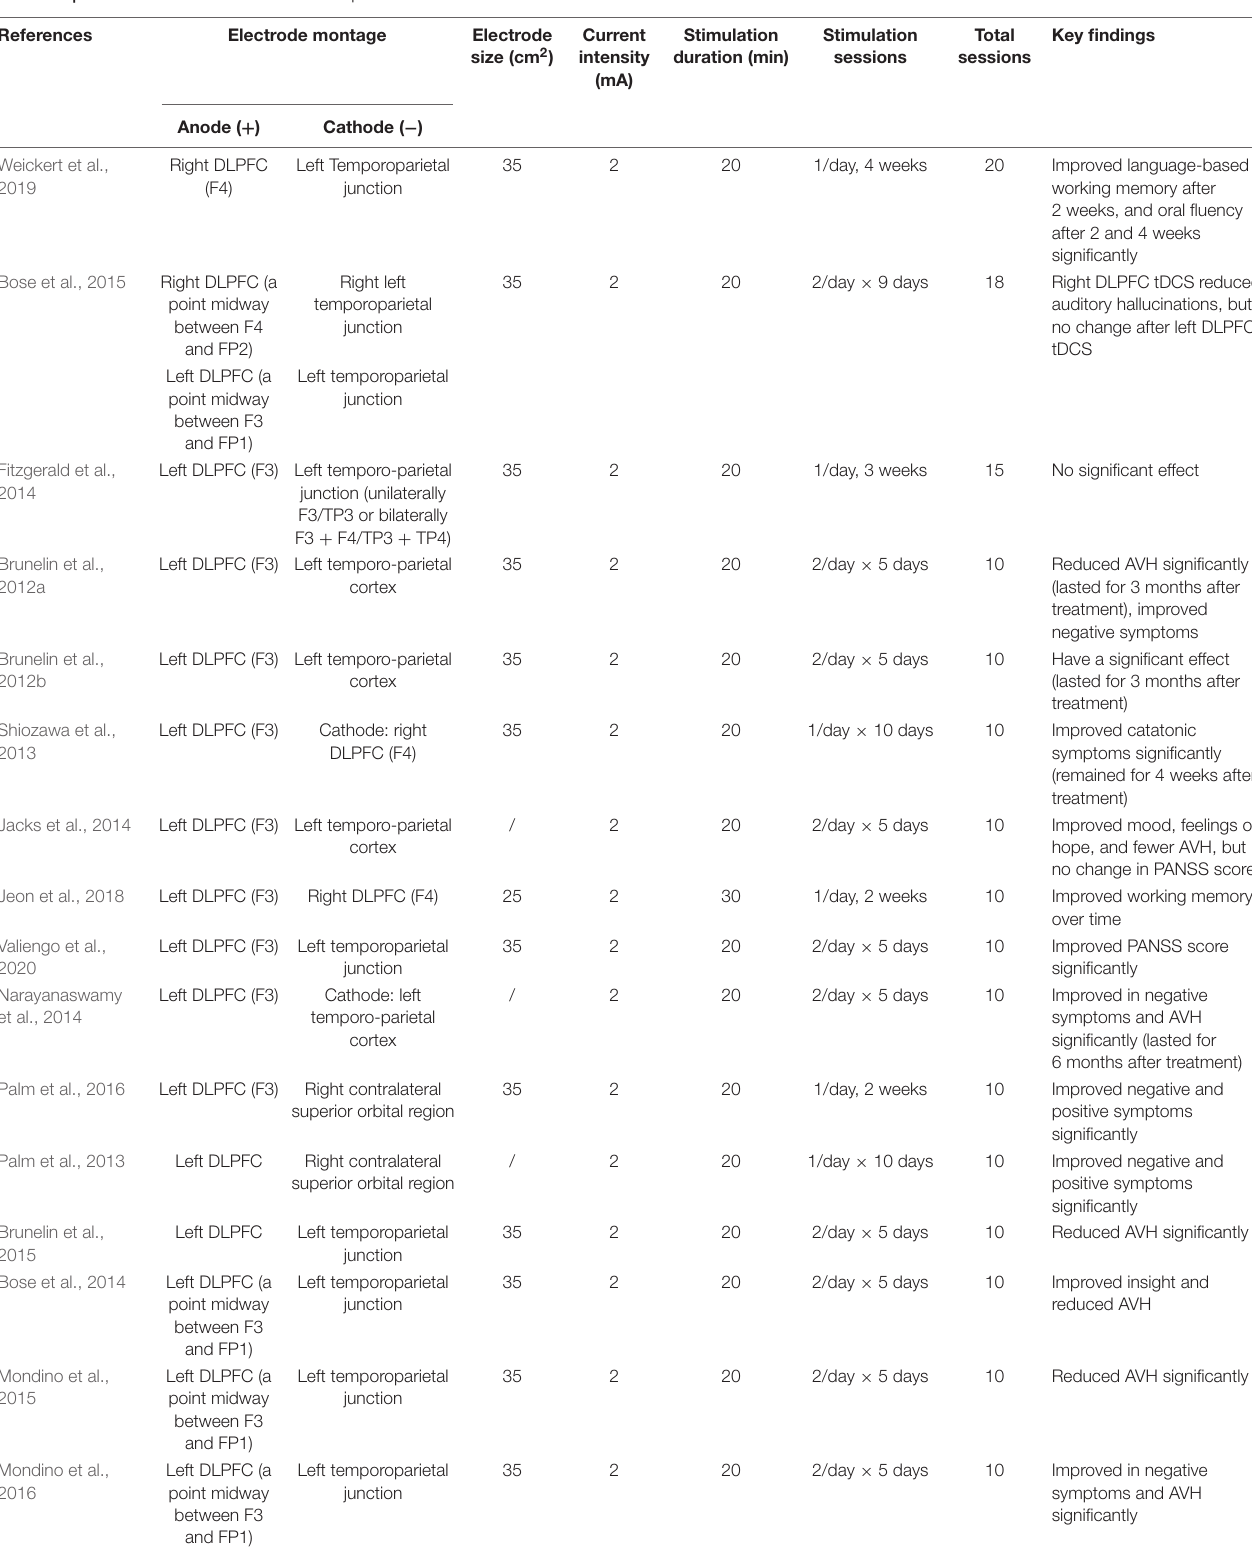
TABLE 2 | Effects of tDCS of DLPFC on